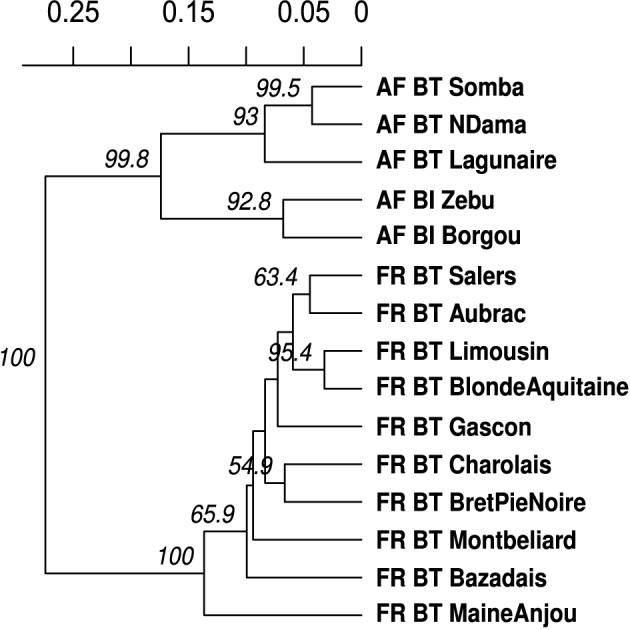
UPGMA dendrogram generated from Nei's genetic distance on 15 breeds of
Bos taurus
(BT) or
Bos indicus
(BI) from Africa (AF) or France (FR). These data are from Laloë et al. (2007). Node labels represent bootstrap support (>50%) out of 1000 bootstrap replicates.